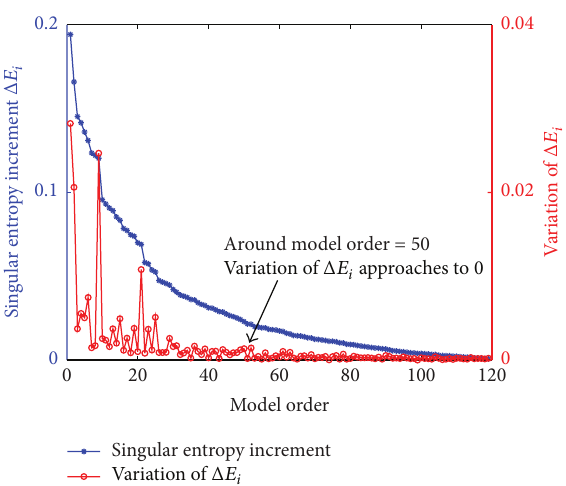
Figure 8: The footbridge: the change of singular entropy increment and its variation with model order.